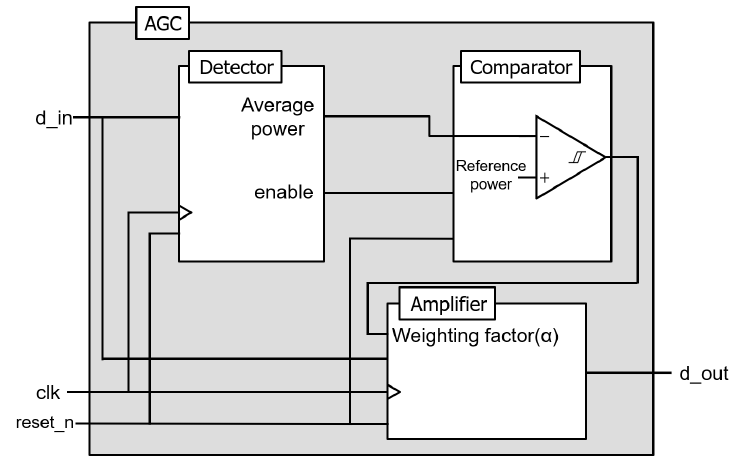
Figure 10. Block diagram of the proposed digital AGC.